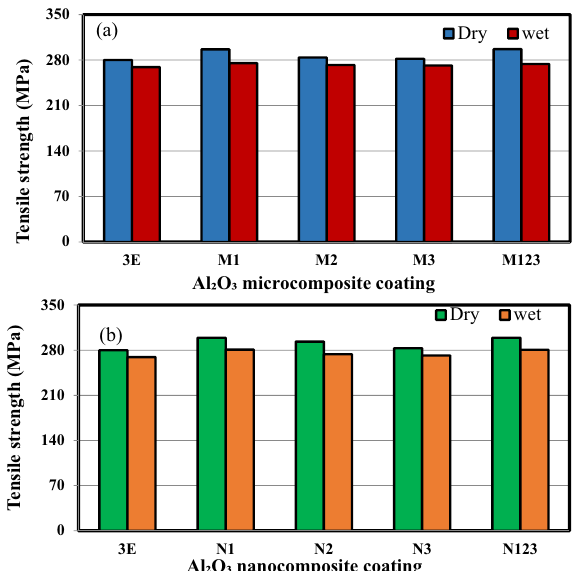
Figure 4. The tensile strength of multilayers epoxy coating to steel substrate filled with ( a ) Al 2 O 3 microparticles ( b ) Al 2 O 3